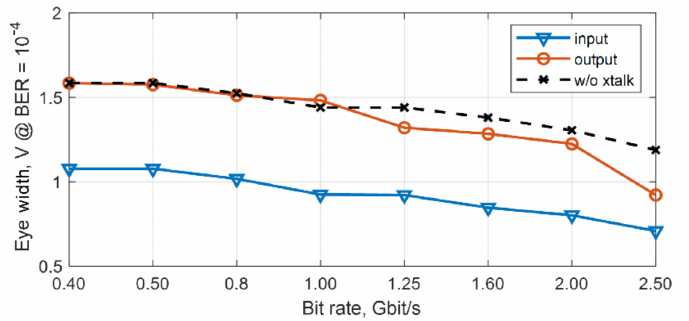
Figure 16. Eye-opening width versus bit rate from 0.4 Gbit/s to 2.5